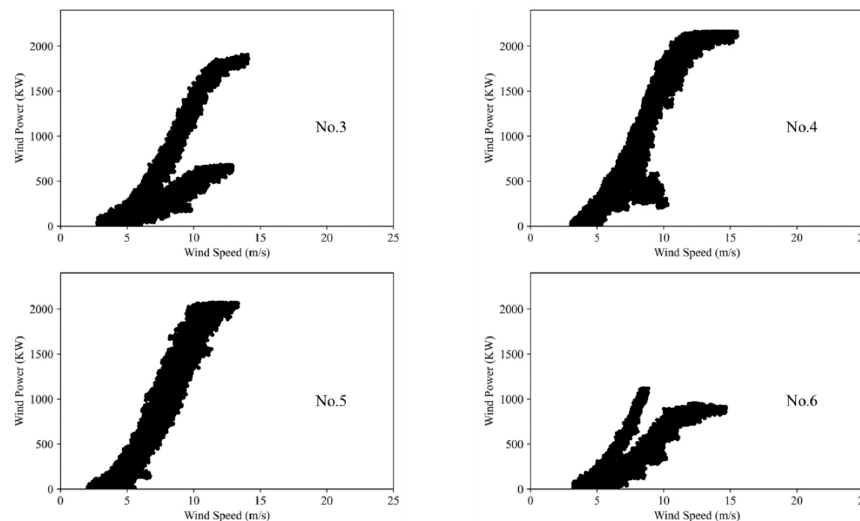
Figure 6. Abnormal data filtering result via MMO.